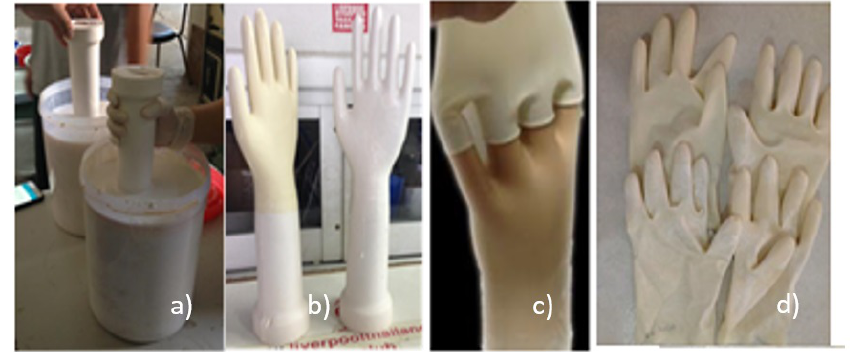
Figure 3: Rubber latex glove film preparation: a) dipping porcelain and bone china hand molds fired at 1270 ∘ C for 10 h coated with CaCl 2 prepared from eggshell into rubber latex compound; b) rubber latex glove film on hand mold surface after curing; c) removing glove film